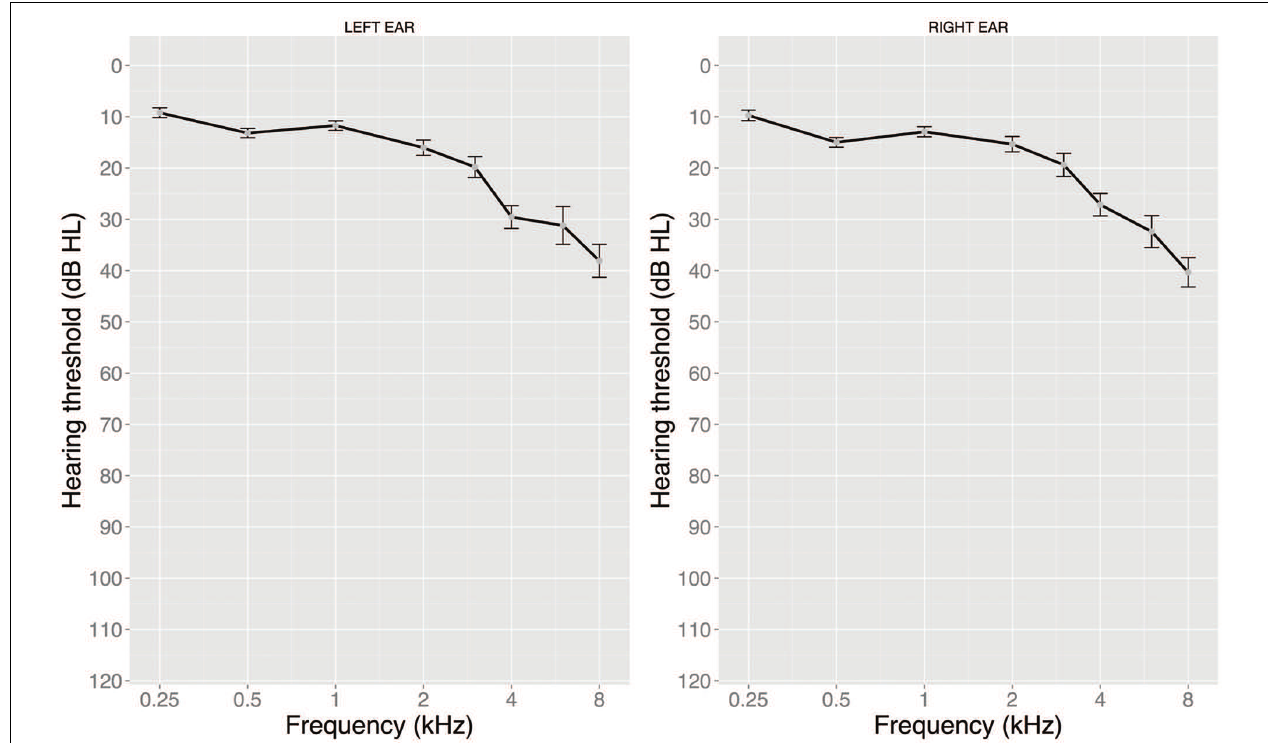
FIGURE 1 | Mean audiometric pure-tone air conduction thresholds (for left and right ear) as a function of frequency. Error bars represent standard errors.